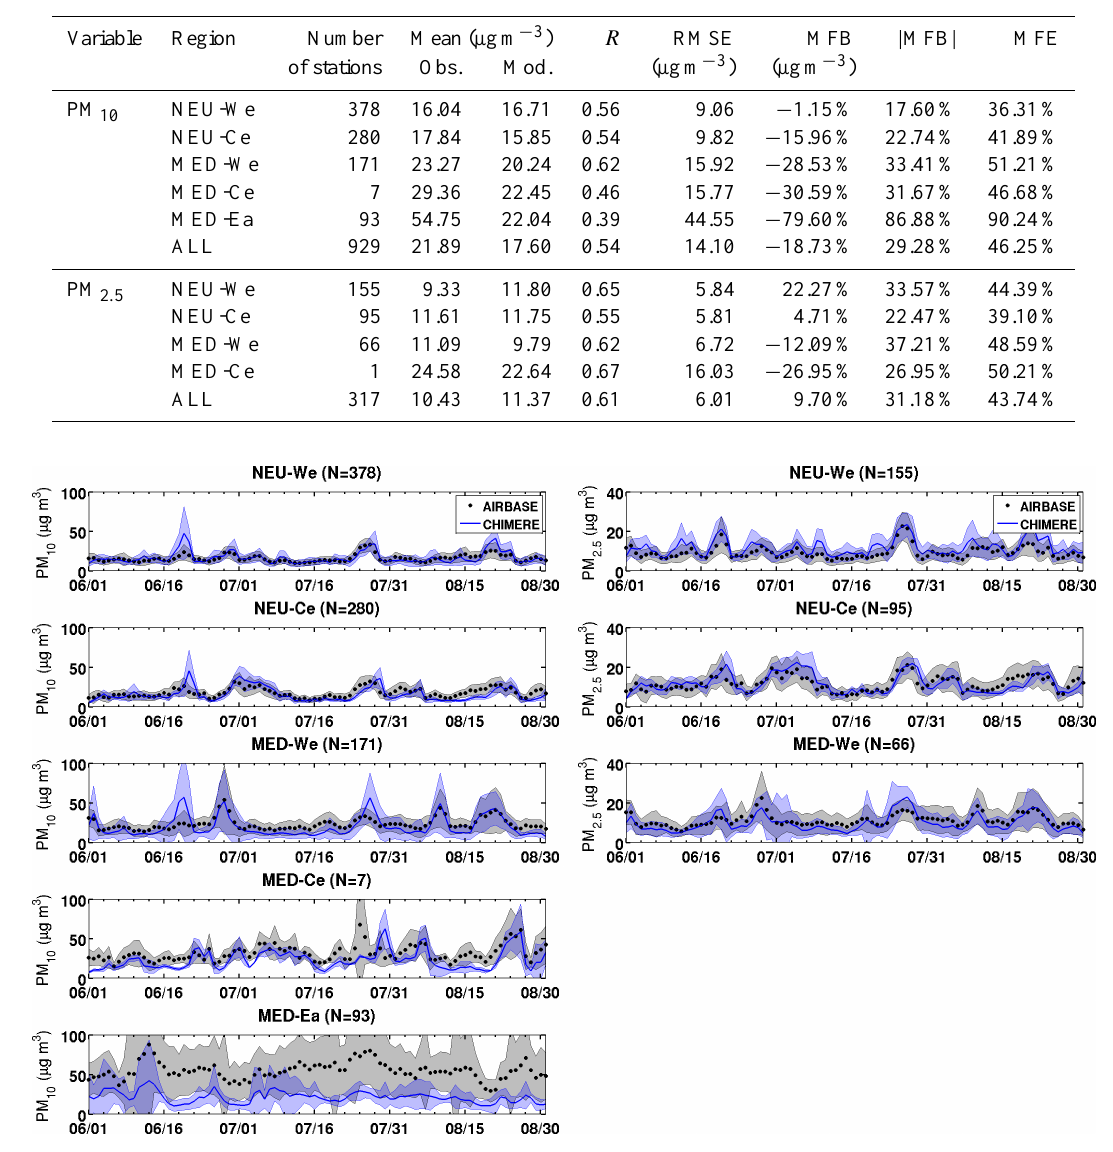
Figure 6. Temporal evolution during the summer of 2012 of observed daily mean surface PM 10 (left column) and surface PM 2 . 5 (right column) concentrations at AirBase and the two ChArMEx rural stations in Corsica (number in each region indicated by the value of N ), in addition to corresponding and collocated simulated daily mean surface concentration from CHIMERE (blue line). The corresponding standard deviation is indicated by a shaded